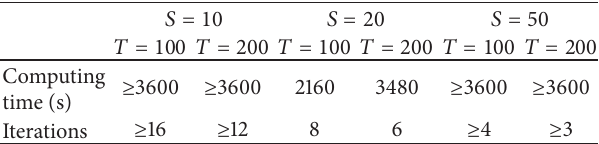
Table 9: Comparison of different algorithm parameters. 𝑆 =